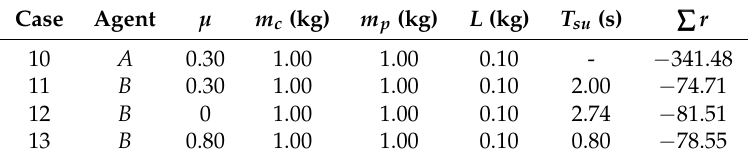
Table 3. Cases of the sensitivity analysis of the dry friction influence on the agent performance.